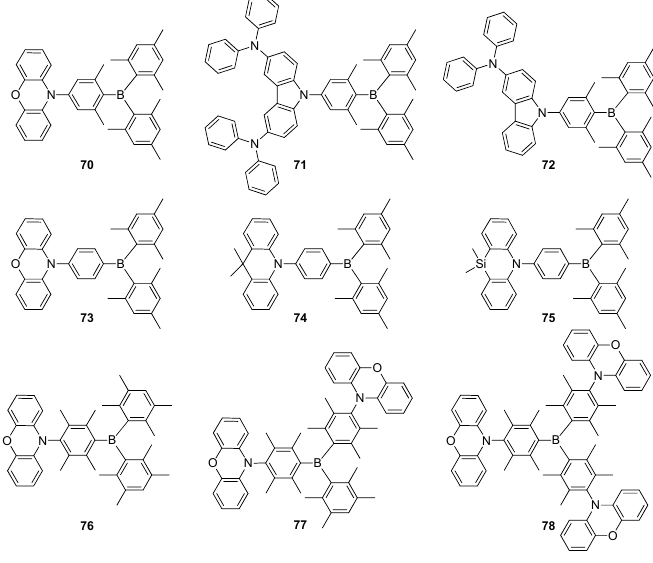
Figure 12. Triarylborane-based TADF materials 70 – 78 .